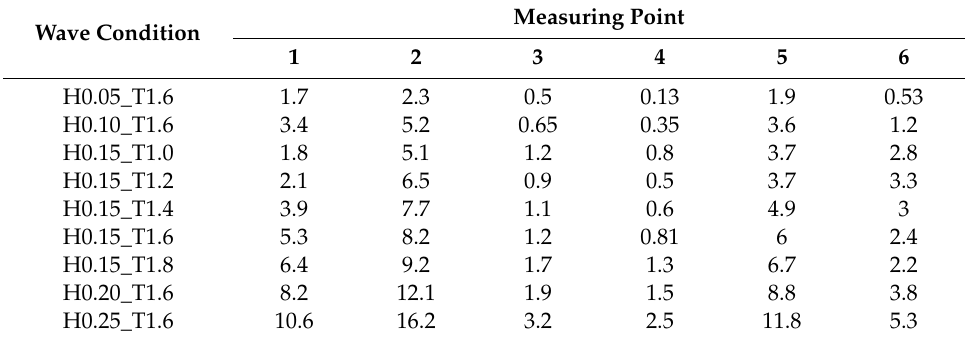
Figure 7. Time-series of the strain response at various measurement positions in waves. Wave condition: H = 0.15 m and T = 1.4 s. Table 7. Strain-response values at various measurement positions in waves (unit: με ).